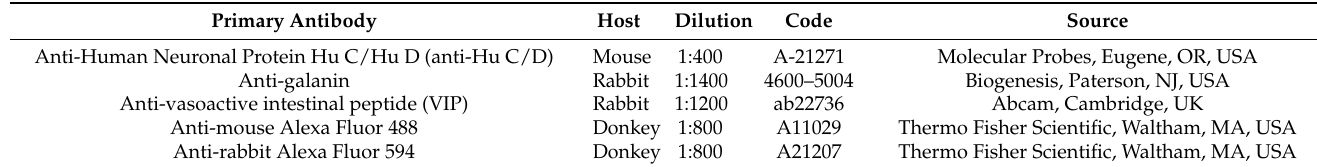
Table 1. Characteristics of primary and secondary antisera used for immunofluorescence